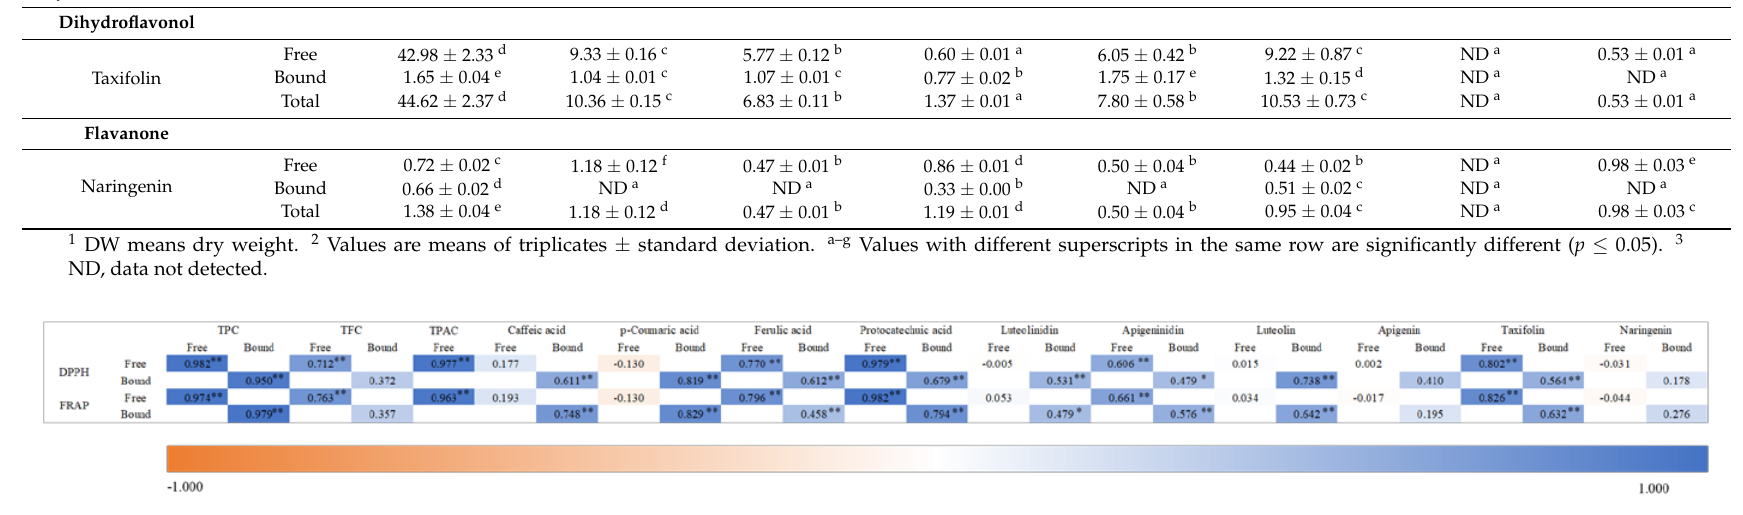
Figure 3. Pearson’s correlation coefficients of total phenolics, total flavonoids, total proanthocyanidins, individual phenolic compounds and antioxidant capacities. Blue color indicates good positive correlation (close to 1), white means low correlation (close to 0) and orange indicates good negative correlation (going to − 1). Data with double asterisk (**) and single asterisk (*) are statistically significant at p level < 0.01 and p level < 0.05, respectively.